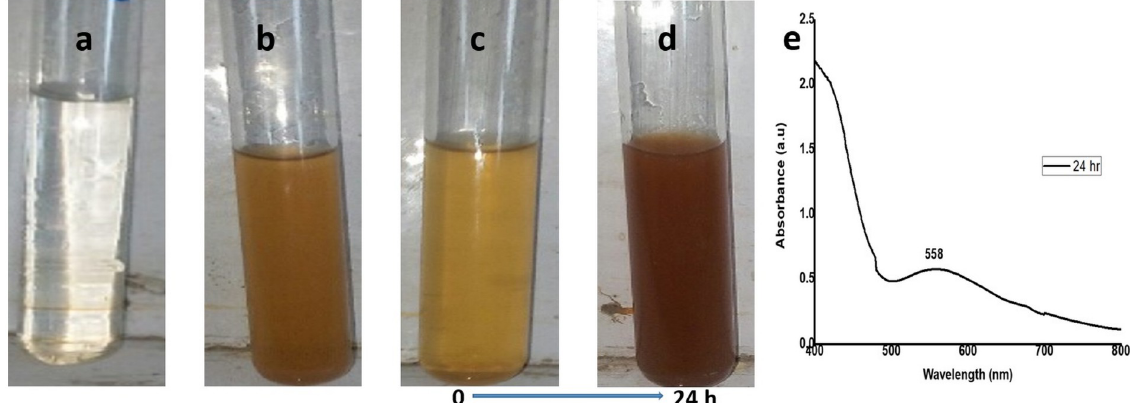
Fig 1. Synthesis of CuNPs. a copper sulfate solution. b plant extract. c mixture of copper sulfate solution and plant extract at zero-time. d change in color of solution after 24 h of time lap. e UV-visible spectrograph of CuNPs.